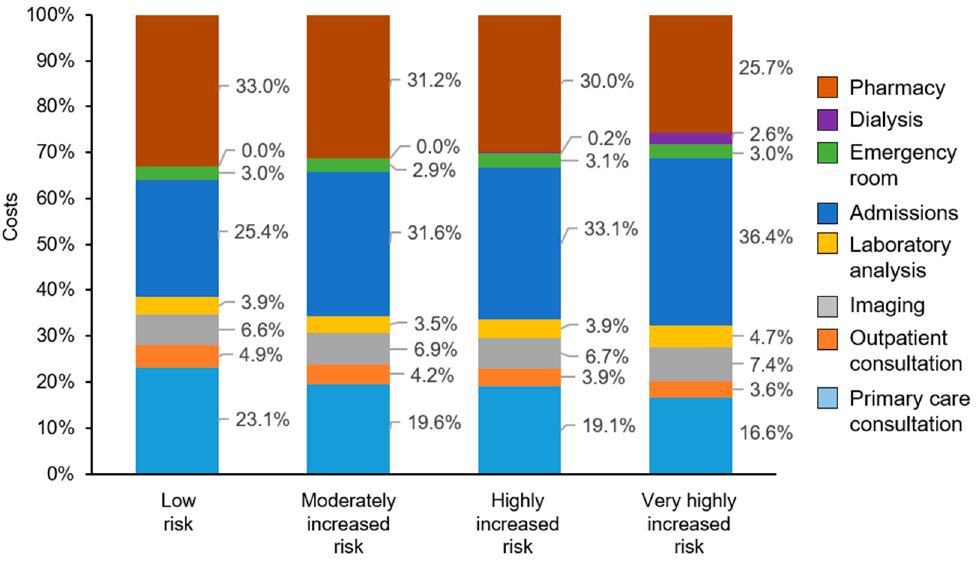
Figure 3. Distribution of total costs associated to each KDIGO risk group.